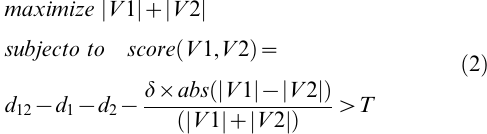
Figure S1 Comparison of the size distribution of pathways identified by our method with that identified by Kelly/Ideker and Ulitsky/Shamir, using the same size constraint parameters and original datasets. Upper panel: size distribution of non-redundant pathways identified by our algorithm on the data used by Kelly/ Ideker; Bottom panel: size distribution of non-redundant pathways identified by our algorithm on the data used by Ulitsky/Shamir. Figure S2 Permutation distribution of b . A large fraction (21%) of permutation b had value of 0. For non-zero b , the mean was 0.091 and the standard deviation was 0.058. Figure S3 Distribution of pathway size differences under different penalty parameter d . Found at: doi:10.1371/journal.pone.0001922.s003 (0.01 MB TIF) Figure S4 Distribution of pathway completeness under different penalty parameter d . Found at: doi:10.1371/journal.pone.0001922.s004 (0.01 MB TIF) Text S1 Minimum pathway size parameter Found at: doi:10.1371/journal.pone.0001922.s005 (0.03 MB DOC) Text S2 Between-pathway completeness b . Found at: doi:10.1371/journal.pone.0001922.s006 (0.03 MB DOC) Text S3 Within-pathway completeness a . Found at: doi:10.1371/journal.pone.0001922.s007 (0.02 MB DOC) Text S4 Pathway size imbalance penalty d